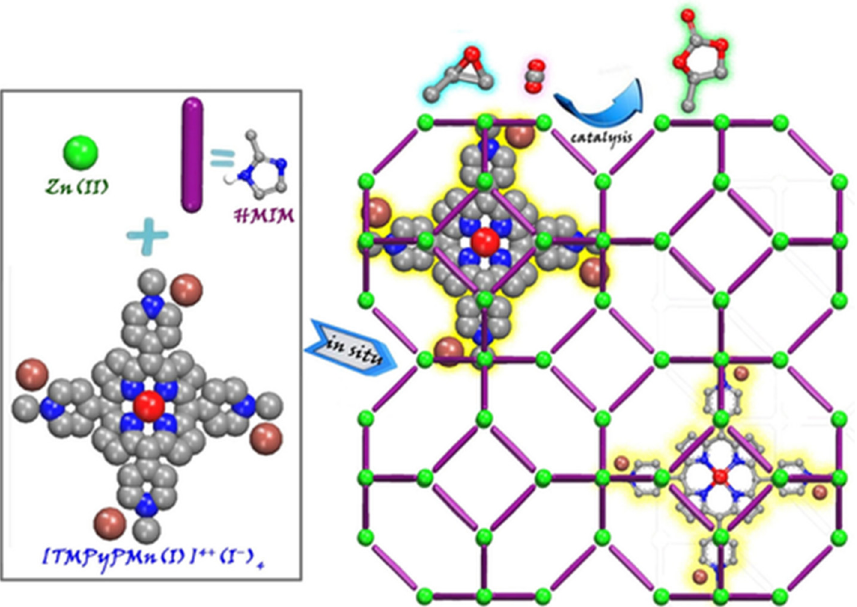
Figure 4. Illustrative demonstration of in situ enveloping of metalloporphyrin into ZIF-8 to conjoin CO 2 to epoxide. Reprinted with permission from [49].